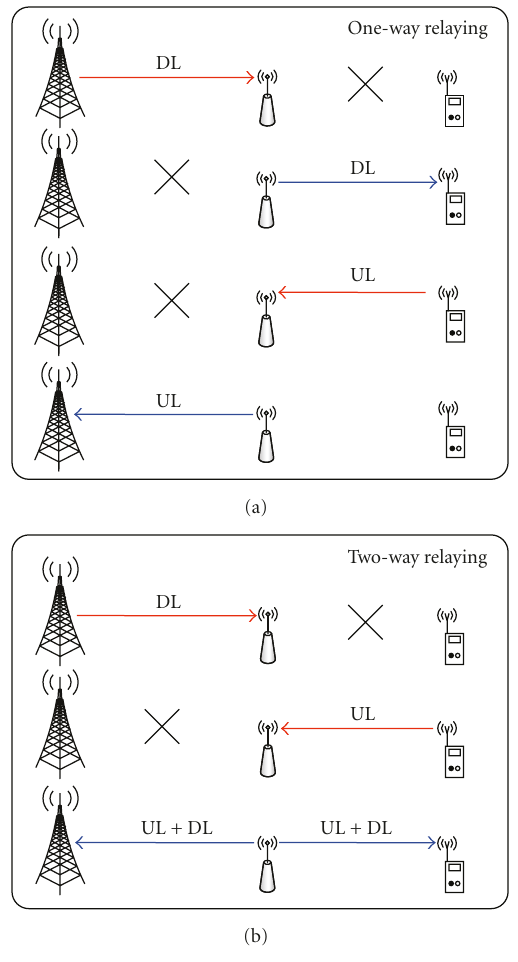
Figure 2: One-way and two-way transmission protocols.